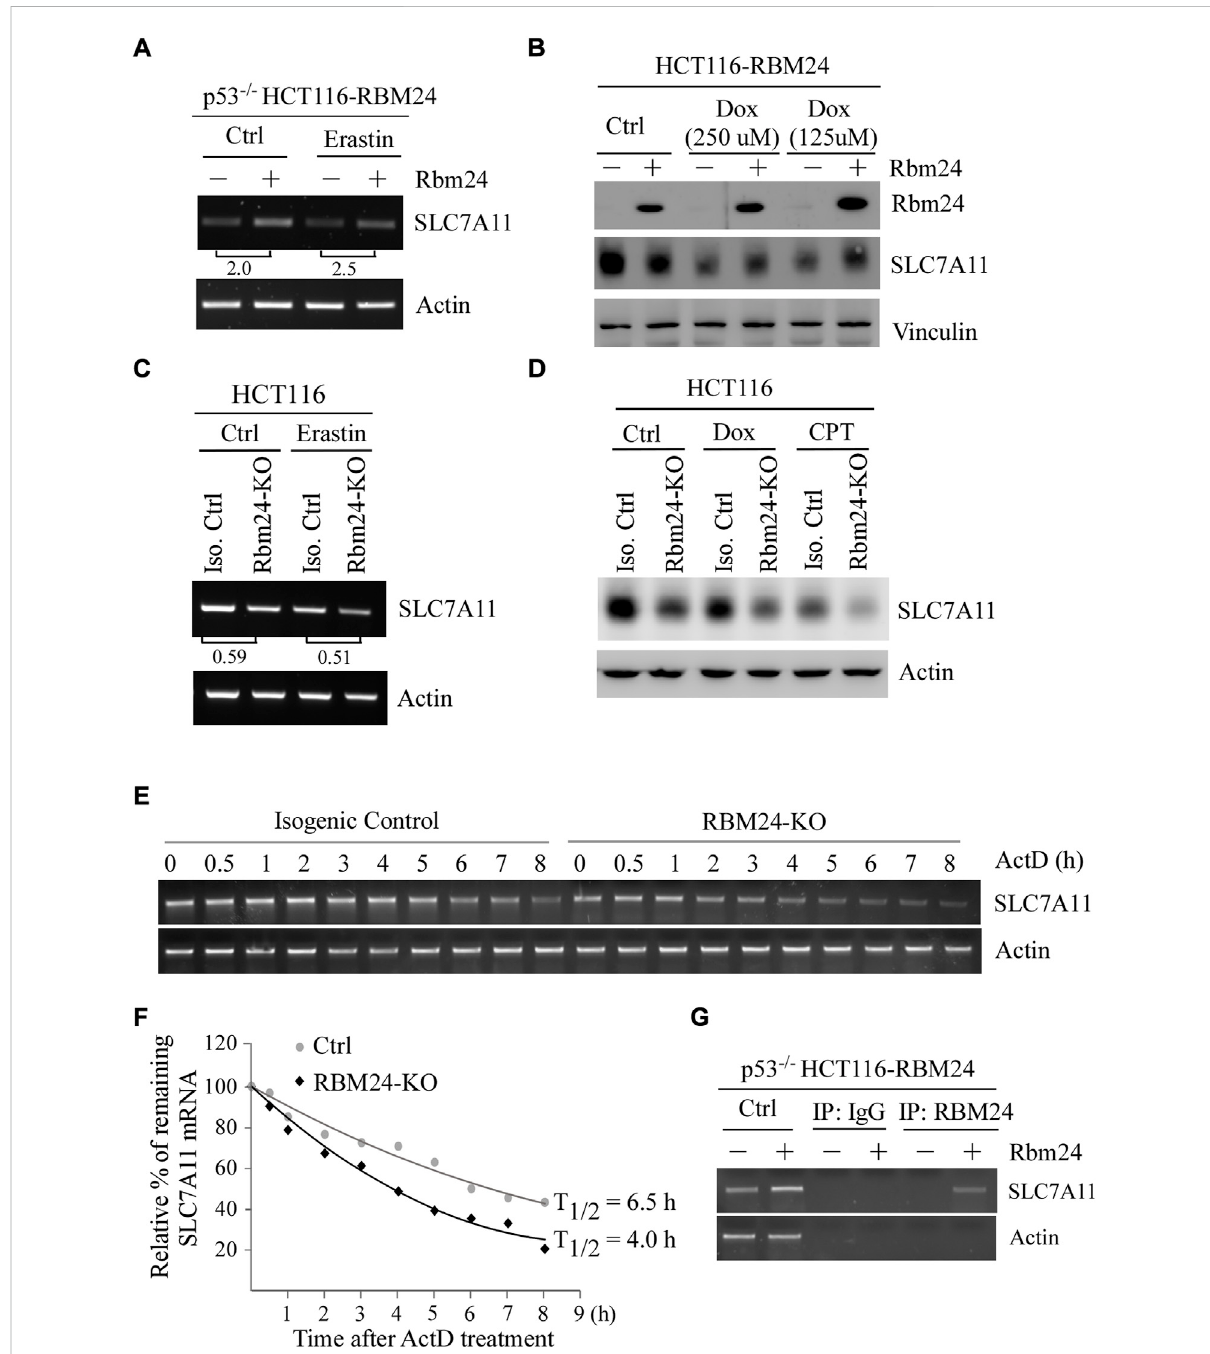
RBM24 inhibits ferroptosis via modulating SLC7A11 expression. (A) The level of SLC7A11 mRNA was measured in p53 − / − HCT116 cells with or without RBM24 expression, followed by mock treatment or treatment with Erastin (40 mM) for 8 h. The relative fold change of SLC7A11 transcript was calculated by dividing the relative abundance of SLC7A11 transcript in RBM24-epxressing cells by the one in control cells. (B) HCT116 cells were uninduced or induced to express RBM24 for 24 h, followed by mock or doxorubicin treatment (125 μ M or 250 μ M) for 12 h. The levels of RBM24, SLC7A11 and actin proteins were measured by western blot analysis. (C) Isogenic control and RBM24-KO HCT116 cells were mock-treated or treated with Erastin (40 μ M) for 8 h, followed by RT-PCR analysis to measure the levels of SLC7A11 and actin mRNAs. The relative fold change of SLC7A11transcriptwascalculatedbydividingtherelativeabundanceofSLC7A11transcriptinRBM24-KOcellsbytheoneincontrolcells. (D) Isogenic controlandRBM24-KOHCT116cellsweremock-treatedortreatedwithdoxorubicin(Dox)orcamptothecin(CPT)for12 h,followedbywesternblot analysistomeasureSLC7A11andactinproteins. (E) IsogeniccontrolandRBM24-KOHCT116cellsweremock-treatedortreatedwithactinomycinD (10 μ g/ml) from 0 to 8 h, followed by RT-PCR analysis to measure the levels of SLC7A11 and actin mRNAs. (F) Quanti fi cation of the relative level of SLC7A11 mRNA in (E) normalized to actin by using Visonworks software and densitometry was plotted for the mean ± S.D. (G) p53 − / − HCT116 cells were uninduced or induced to express RBM24 for 24 h and cell lysate was immunoprecipitated with IgG or anti-RBM24 to bring down the RNA- protein immunocomplex. The binding of RBM24 to SLC7A11 or actin mRNA was visualized by